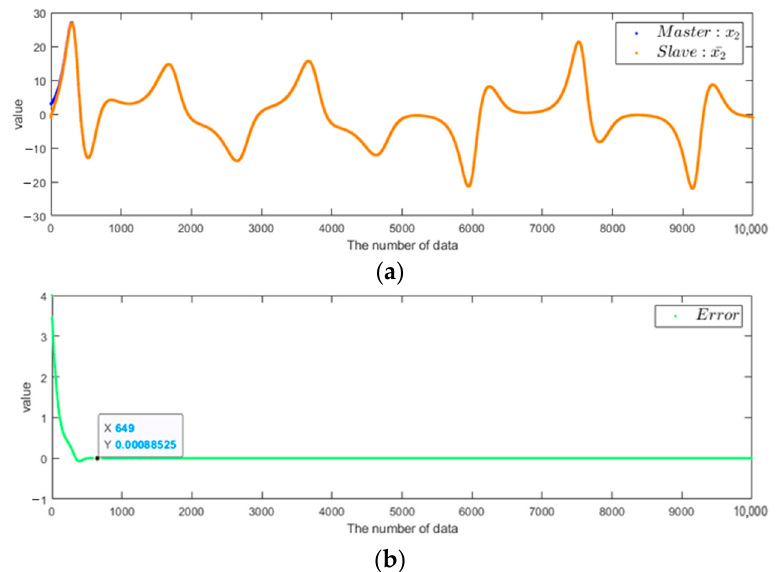
Figure 6. ( a ) Chaotic systems with PD controller; ( b ) The error of the chaotic systems with PD con- troller.